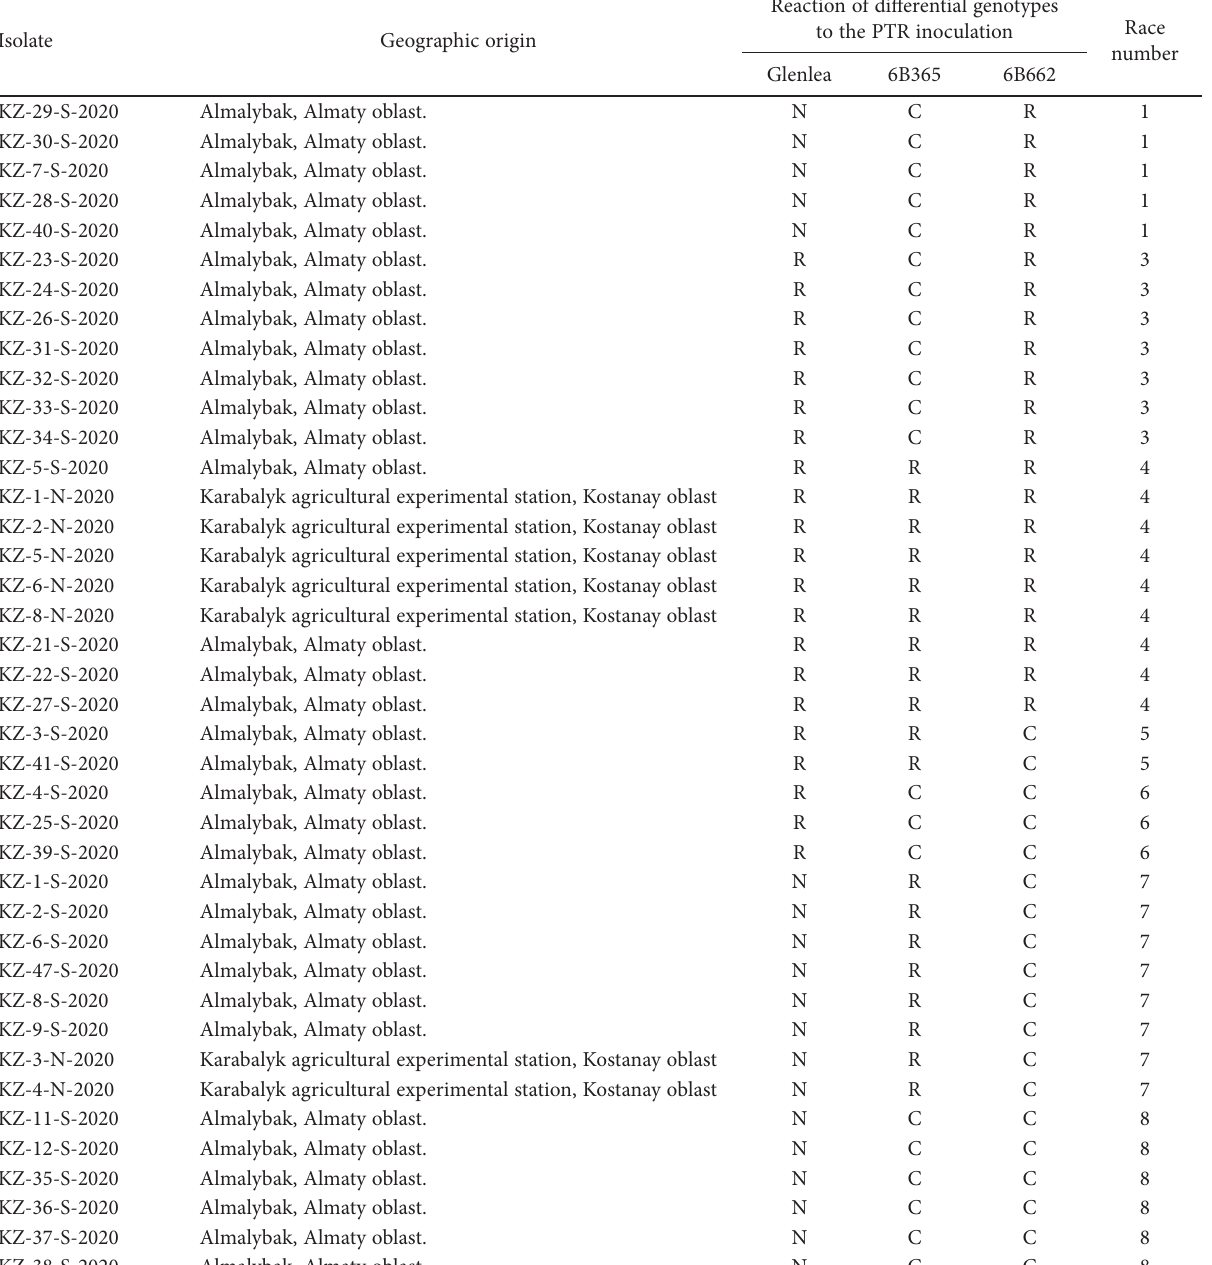
Table 2. Reactions of differential Triticum aestivum genotypes to inoculation with 40 Pyrenophora tritici-repentis isolates collected